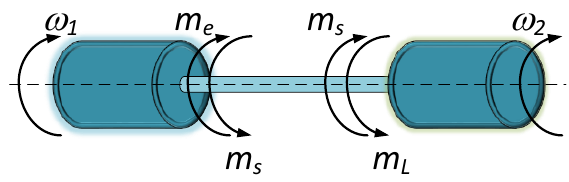
Figure 1. Block diagram of the two-mass system.